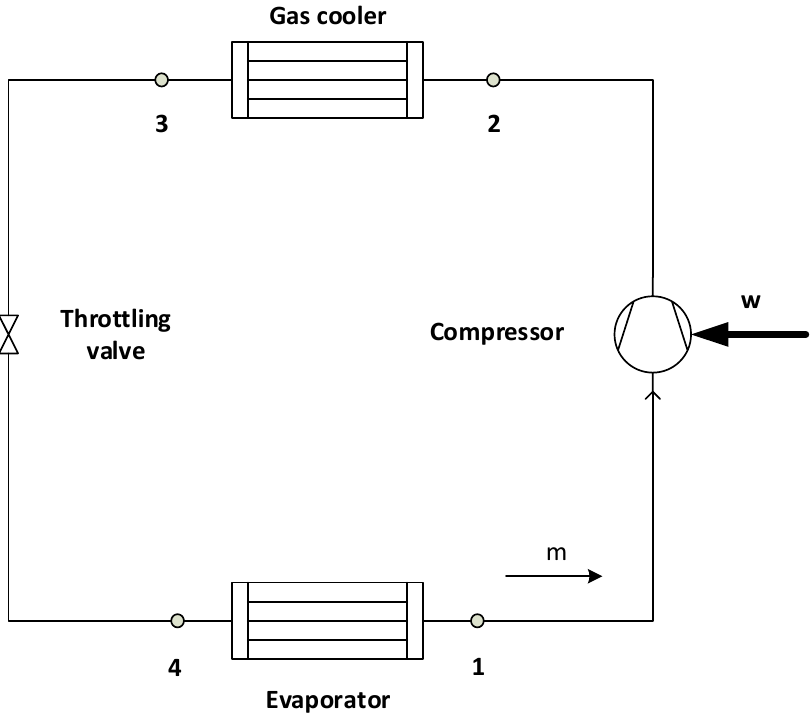
Figure 1. The reference examined system (Ref) which is a simple transcritical refrigeration cycle.